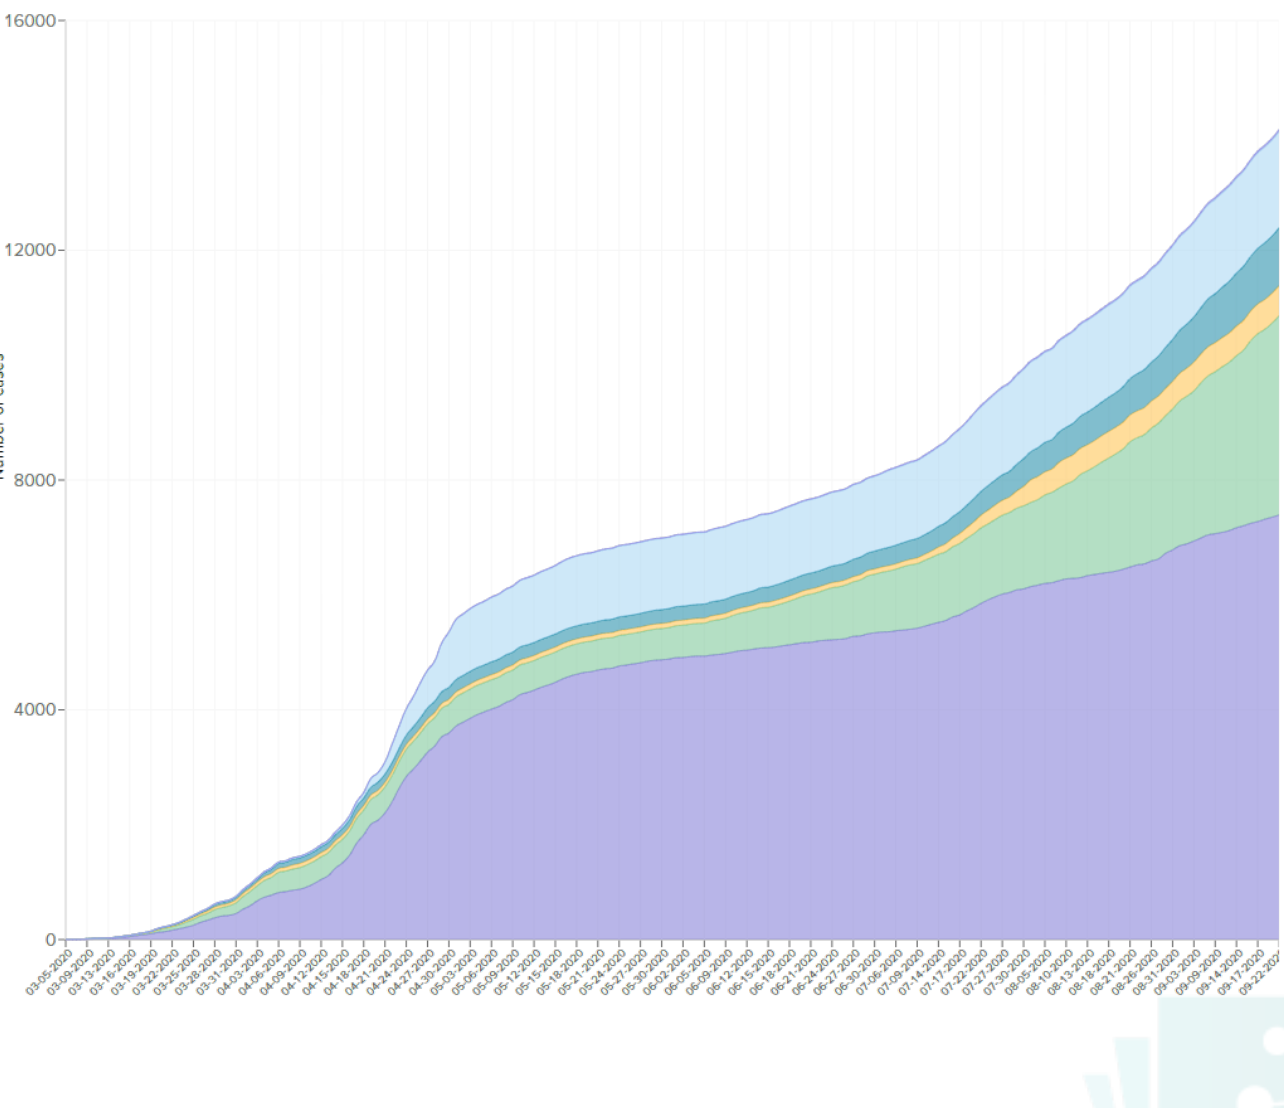
Figure 2: Cases by Health Region in the Selected